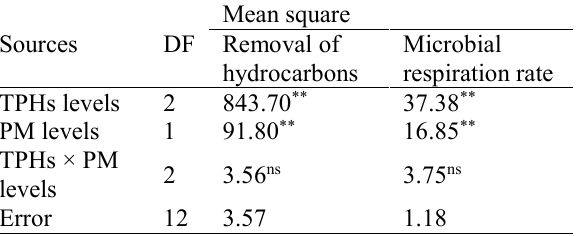
Table 5. Results of ANOVA regarding TPH removal and microbial respiration rate in oat-planted soil Mean square Sources DF Removal of Microbial hydrocarbons respiration rate TPHs levels 2 843.70 ** 37.38 ** PM levels 1 91.80 ** 16.85 ** TPHs × PM 2 3.56 ns 3.75 ns levels Error 12 3.57 1.18